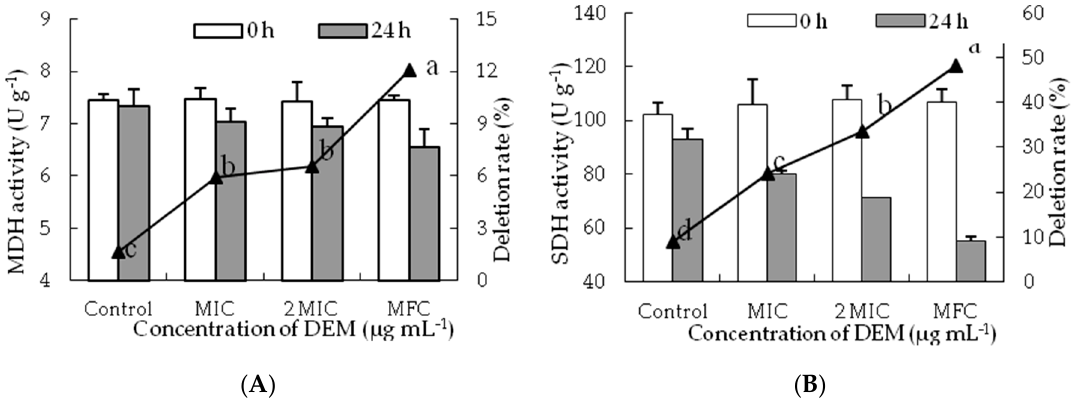
Figure 6. Effect of DEM on the activities of MDH ( A ) and SDH ( B ) of P. italicum